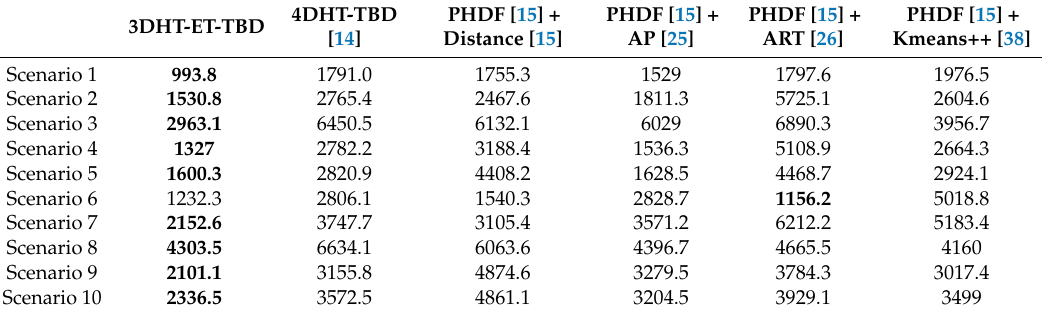
Table 2. The average the optimal sub-pattern assignment (OSPA) distance of the algorithms in 10 scenarios.